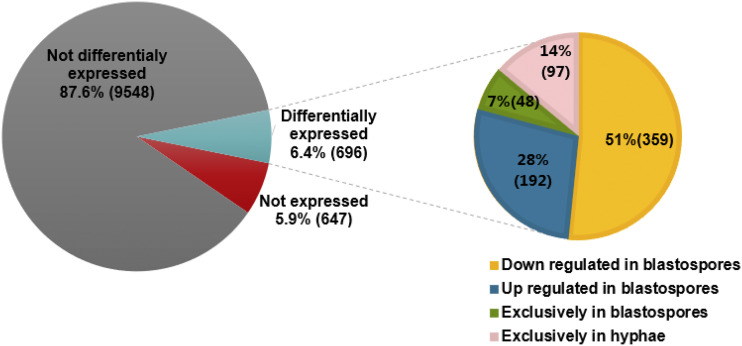
Number of genes differentially expressed in blastospores vs. hyphae. The percentage of genes that are not expressed, not differentially expressed and differentially expressed are shown in the left circle. The right circle shows the percentage of down and up-regulated genes in blastospores and genes exclusively expressed in blastospores or hyphae out of the differentially expressed genes.